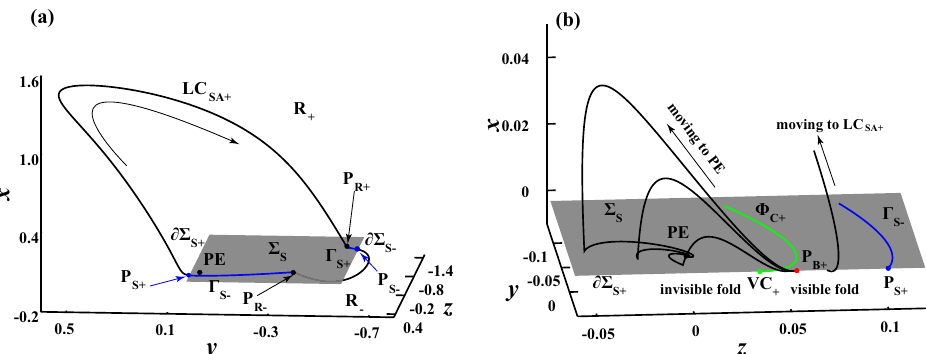
Figure 9. Dynamical structures of rest spike bistability II as well as the local dynamics structure. ( a ) Rest spike bistability II when w = 0.445; ( b ) the local dynamics structure between PE and the sliding segment Γ S −